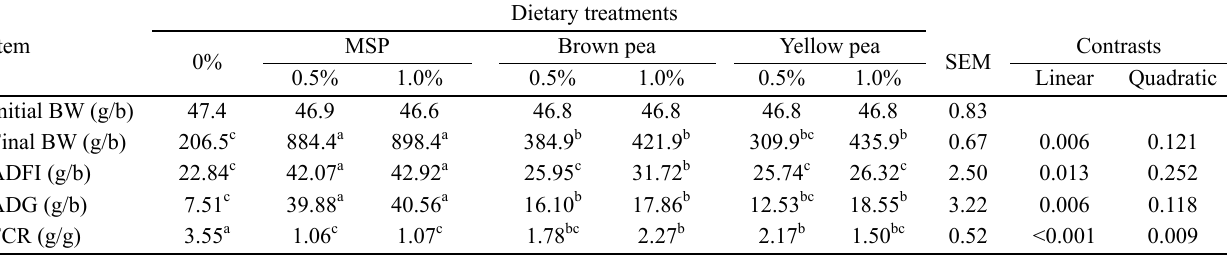
Dietary treatments